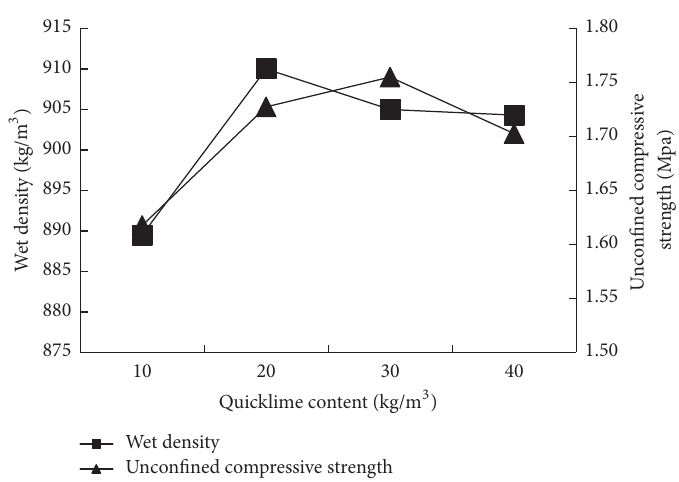
Figure 8: Quicklime content’s influence on wet density and strength of FMLSF.